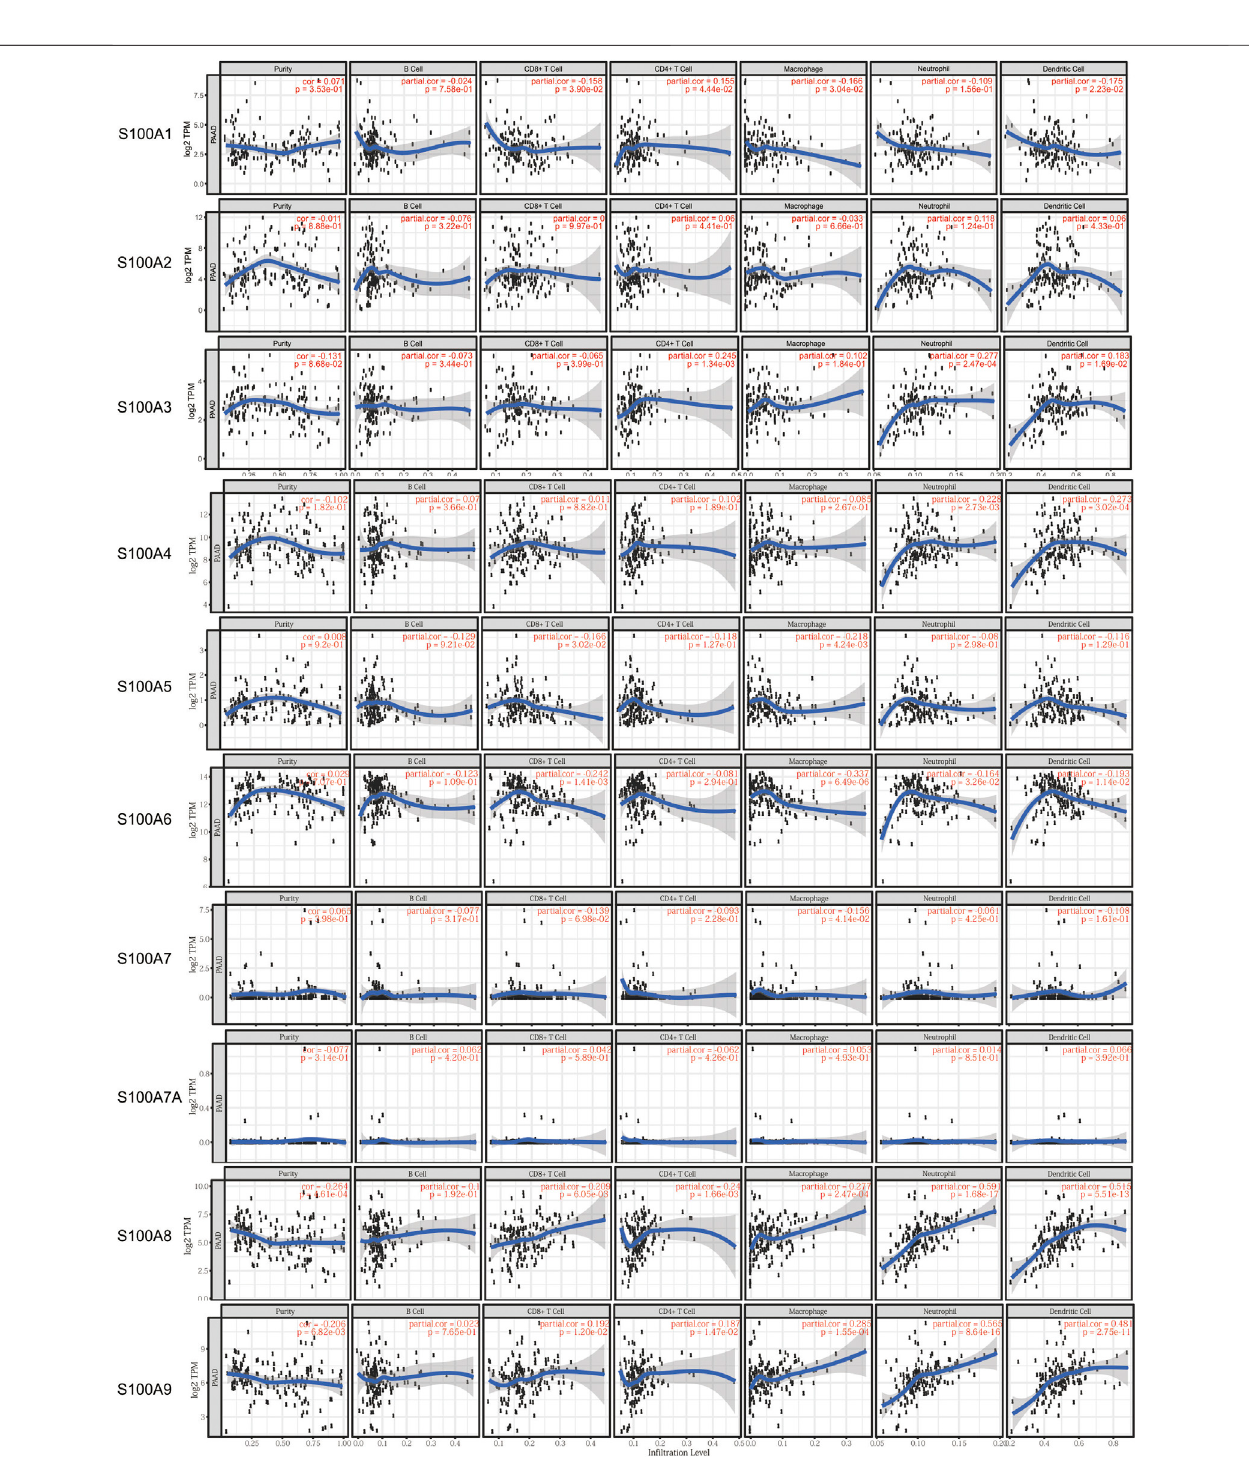
FIGURE 9 | Correlations between S100 gene mRNA expression and immune in fi ltration abundance in PAAD (TIMER database, n (cid:1) 179). The mRNA expression of some S100s factors was correlated with the in fi ltration abundance of B cells, CD8+ T cells, CD4+ T cells, macrophages, neutrophils and dendritic cells.